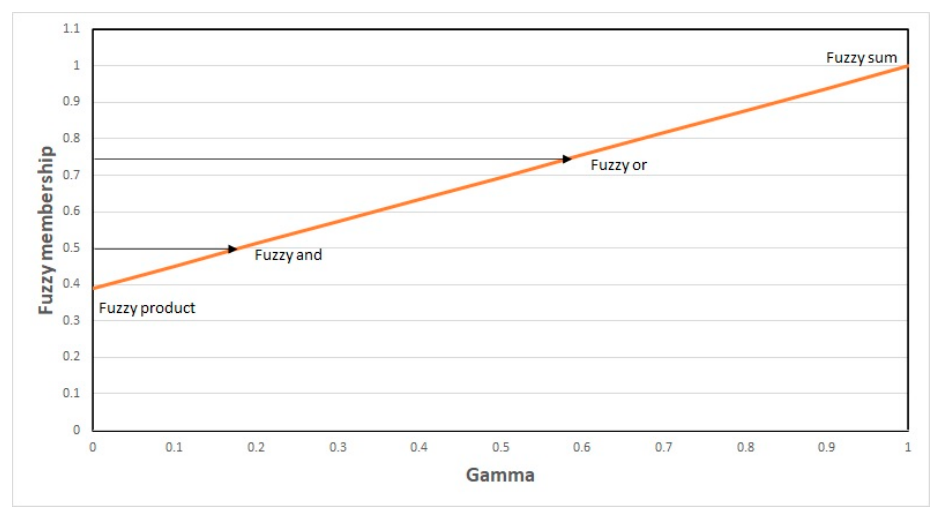
Figure 4. Relationship between Gamma value and other membership functions.